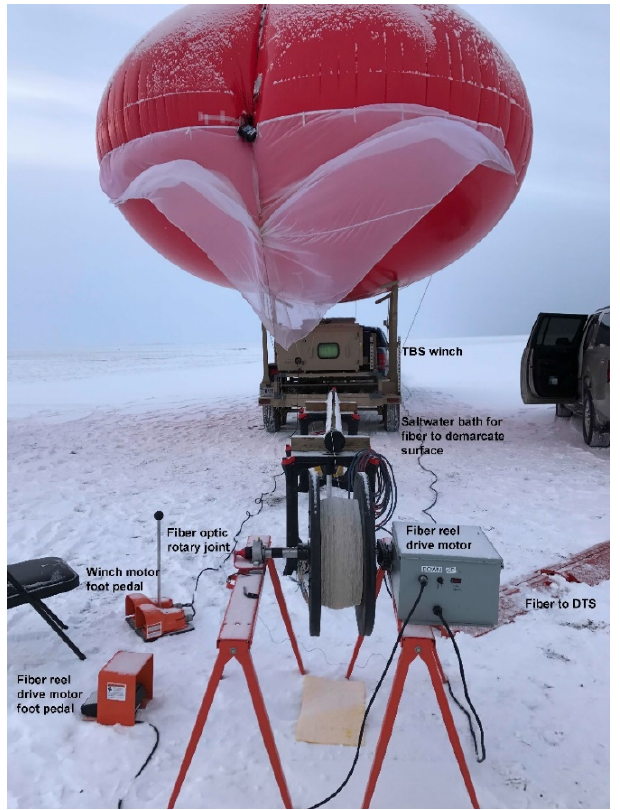
Figure 5. TBS with optical fiber operating through rotary joint and saltwater bath.